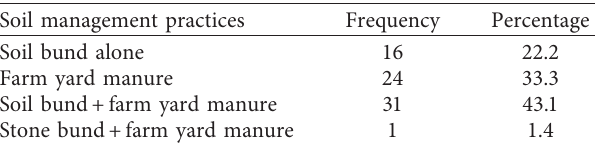
Means for specific soil parameter followed by the same letter(s) are not significantly different from each other at P ≤ 0.05; SMP, soil management practices; NM, no management; SB, soil bund; FYM, farm yard manure management; SBFYM, soil bund integrated with farm yard manure; SEM, standard error of mean; US, upper slope; LS, lower slope. Table 10: Types of soil management practices on Mabula watershed.